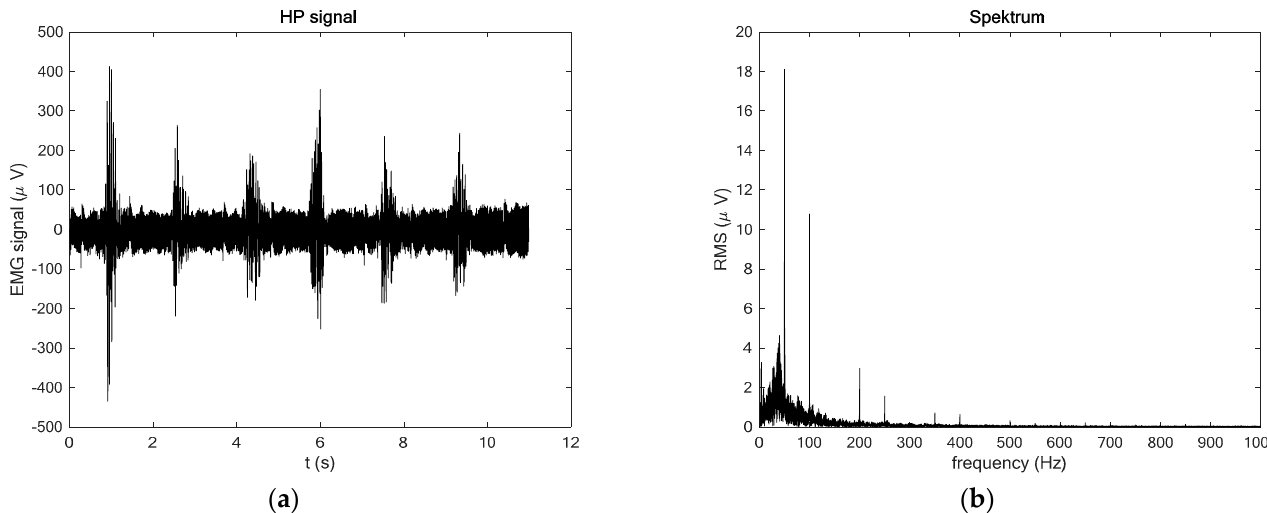
Figure 2. EMG signal with high impact of power line interferences, ( a ) after removing low-frequency part using 3rd order Butterworth HP filter, f c = 2 Hz, ( b ) spectrum for f s = 2 kHz.